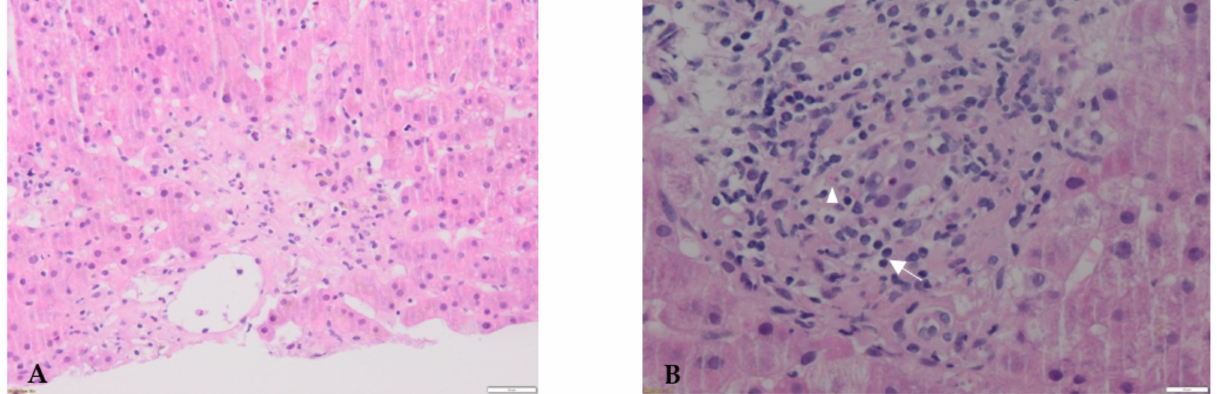
Figure 1. First liver biopsy performed at presentation. Hematoxylin and eosin-stained sections. ( A ): Liver parenchyma is characterized by centrilobular necrosis, sometimes confluent. ( B ): Immune infiltrate predominates around portal areas and is mainly composed of lymphocytes (arrow) and rare eosinophils